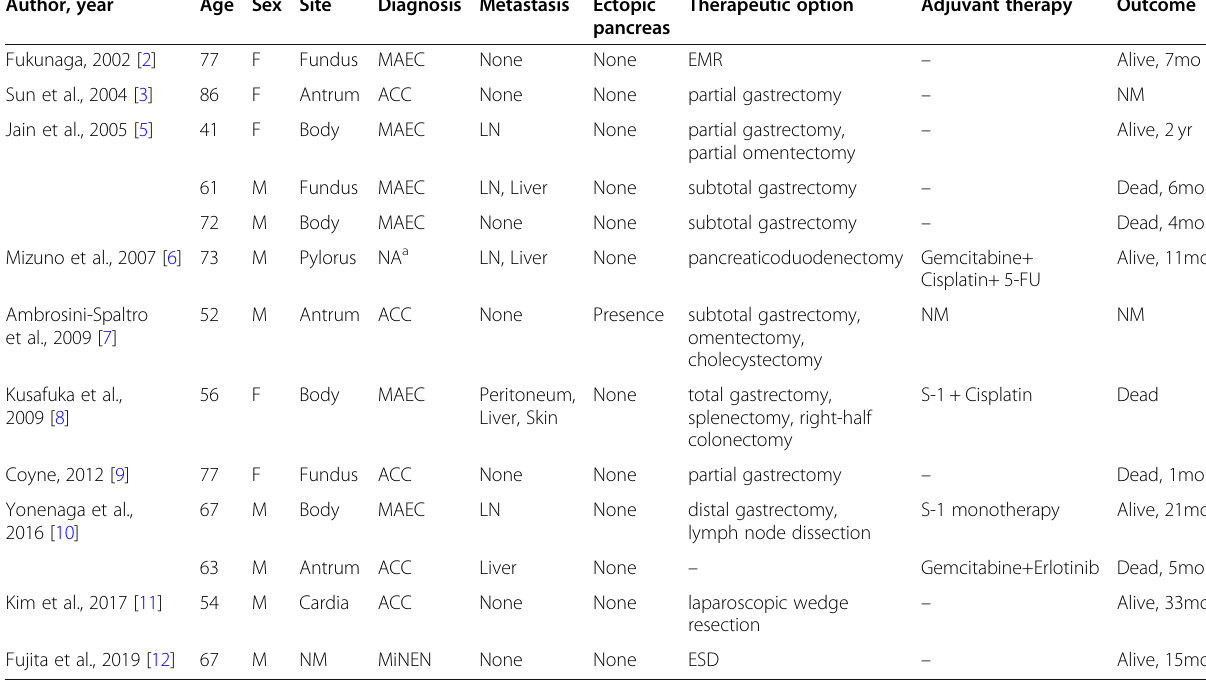
Table 3 List of carcinomas with pancreatic acinar cell differentiation reported in the literature Author,